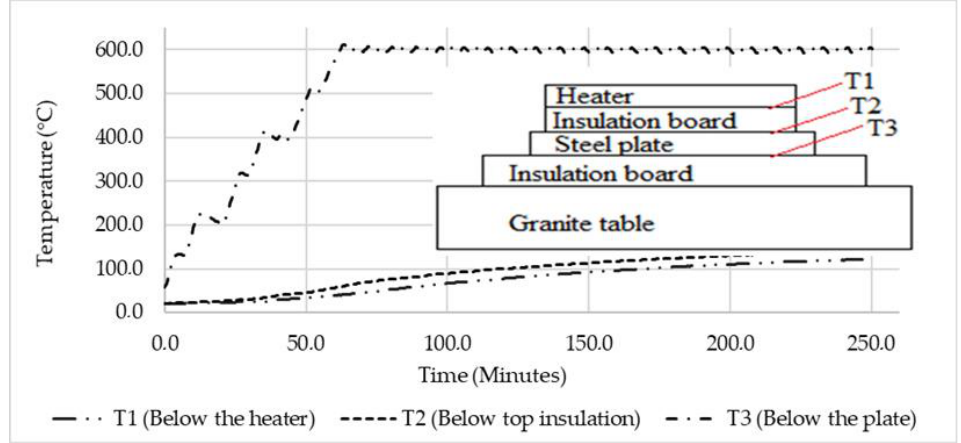
Figure 10. Validation model experimental results.